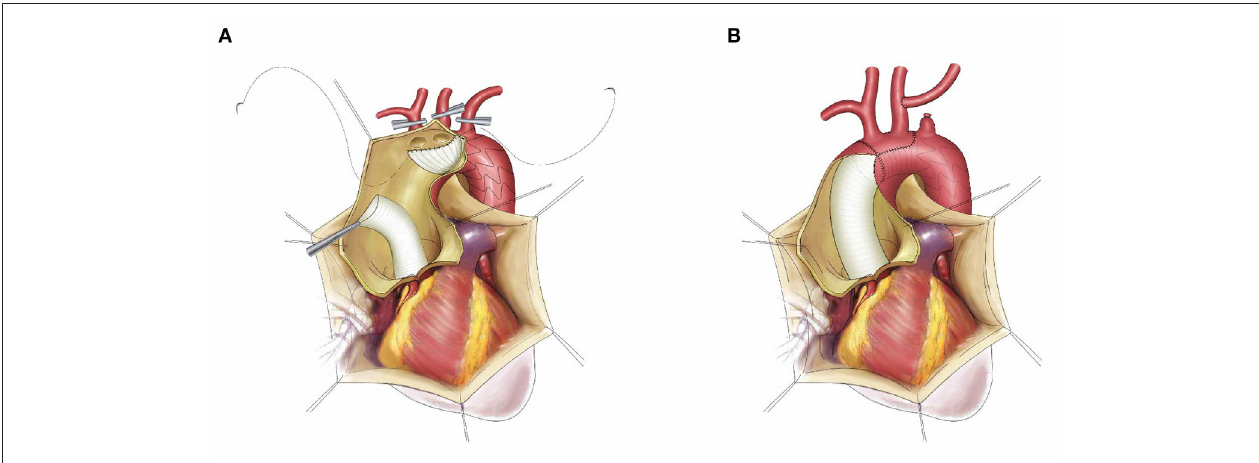
FIGURE 1 | The schematic diagram of frozen elephant trunk with “island technique” and left subclavian aorta to left common carotid artery transposition. The stented graft was inserted into the true lumen of descending aorta, the stent-free vascular graft was trimmed to a semi-oval shape containing the innominate artery and left common carotid artery, then the inner suture was performed counterclockwise while the outer suture was performed clockwise (A) ; The final result after suture, left subclavian aorta to left common carotid artery transposition (B)